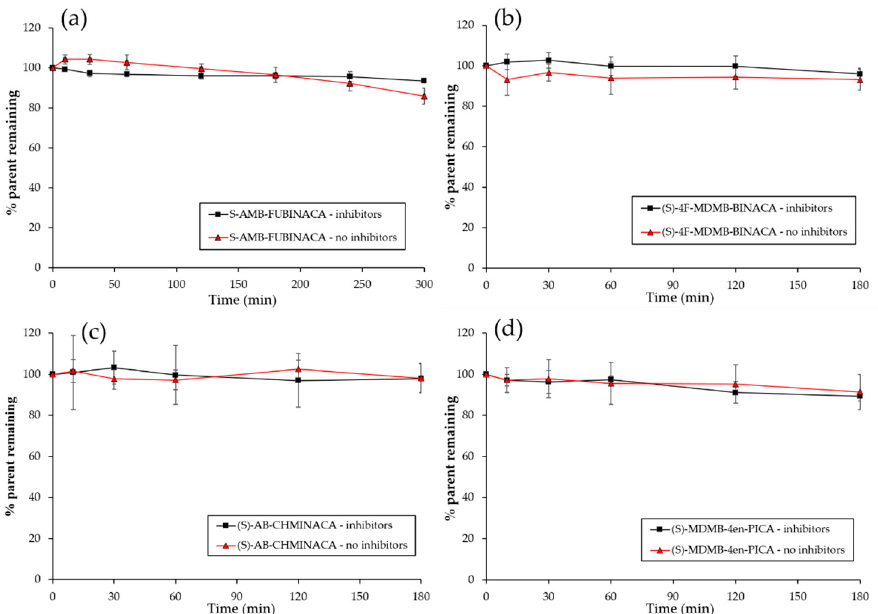
Figure 2. Stability of SCRAs ( a ) ( S )-AMB-FUBINACA ( 1 ); ( b ) ( S )-4F-MDMB-BINACA ( 4 ); ( c ) ( S )-AB-CHMINACA ( 11 ); ( d ) ( S )-MDMB-4en-PICA ( 12 ) in pooled human plasma in the presence and absence of esterase enzyme ( n ≥ 3 ± SD). Full data in Section S5 of the supplementary information.